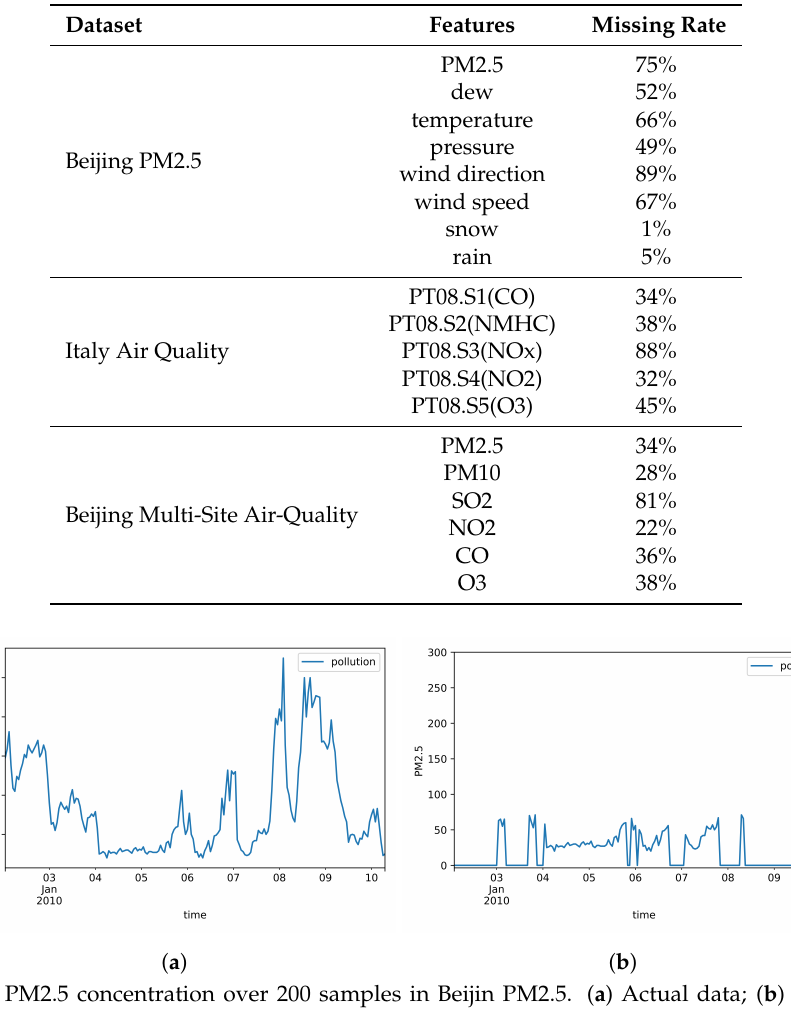
Table 1. Missing rate of datasets features.